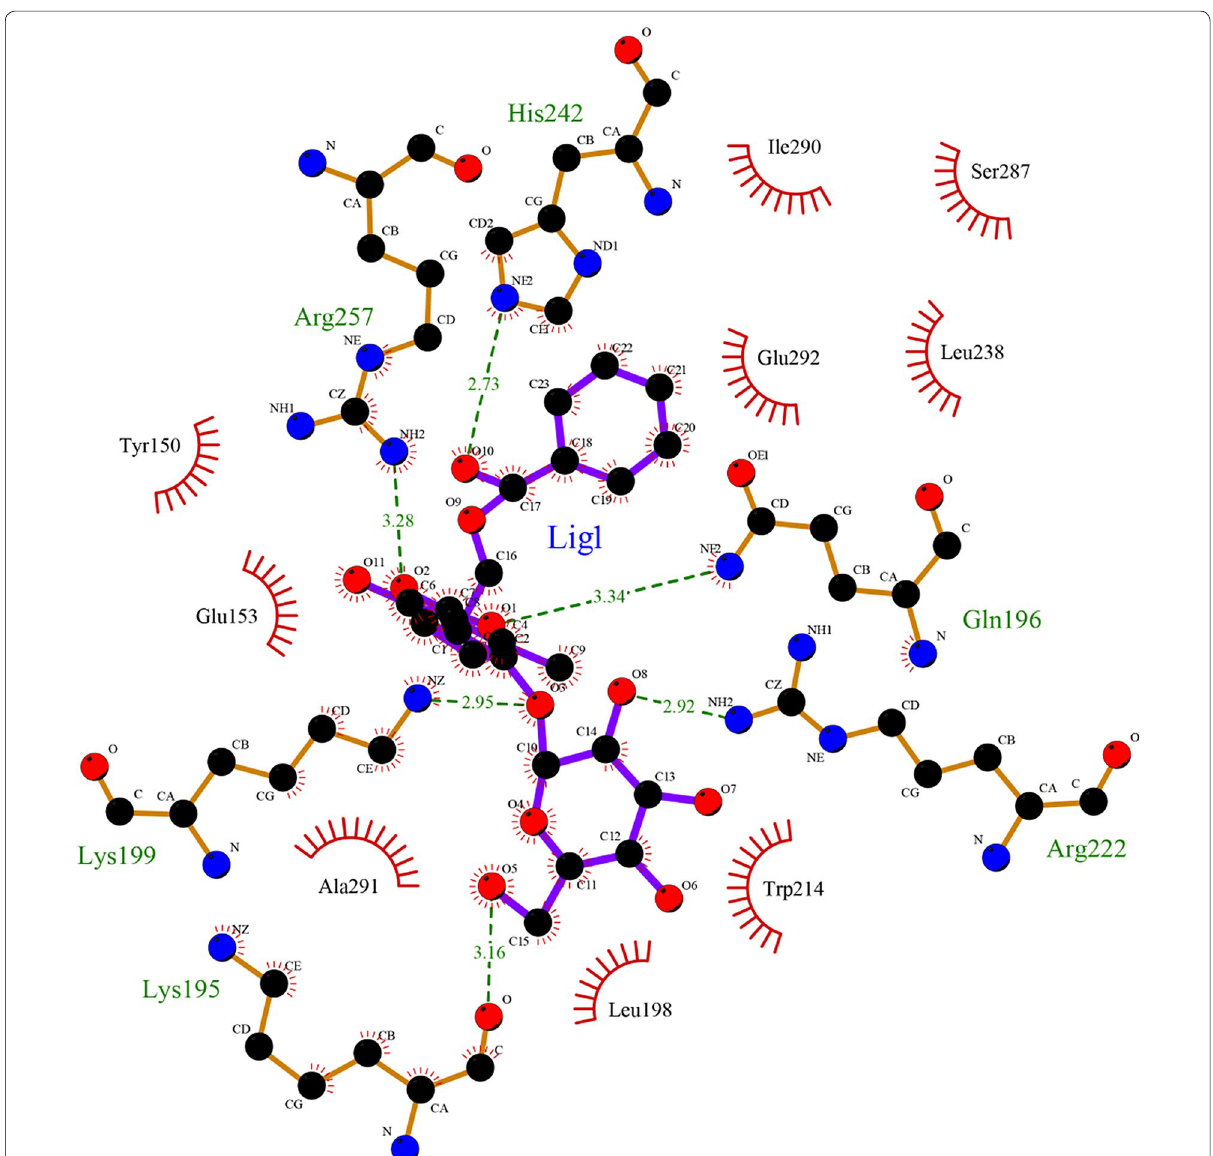
Fig. 13 The interaction model of paeoniflorin at site I of HSA with its hydrogen bodings and hydrophobic